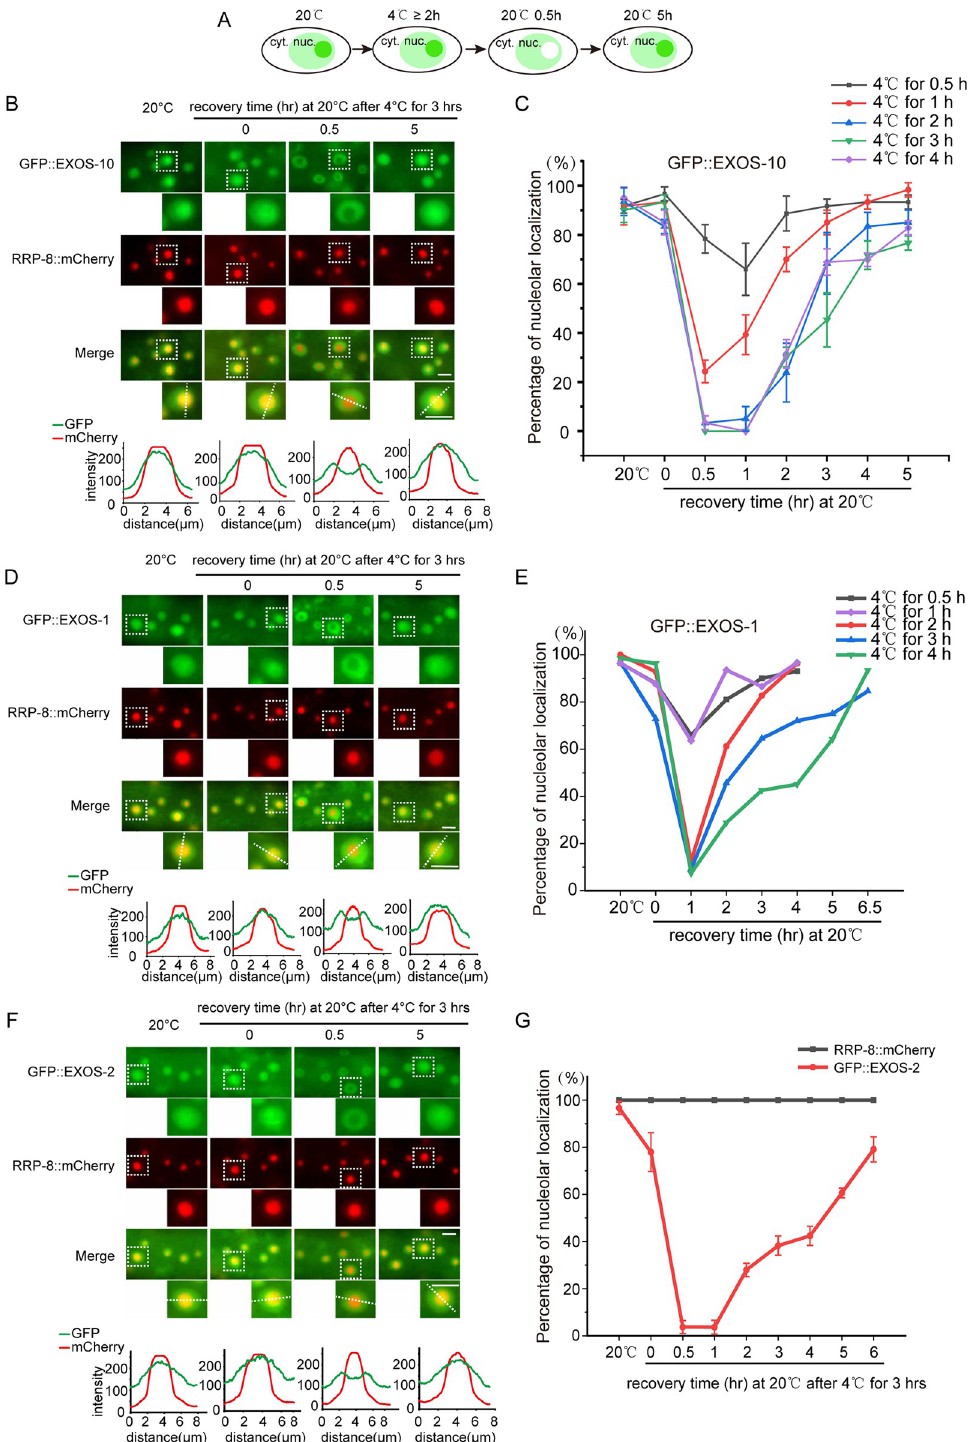
Fig 1. Cold-warm induced depletion of the RNA exosome complex from the nucleoli. (A) The model shows the subcellular localization of EXOS-10 after cold-warm shock. cyt., cytoplasm; nuc., nucleus. (B) Images show epidermal cells of the indicated L3/L4 stage animals expressing GFP::EXOS-10 and RRP-8::mCherry after 4˚C for 3 hours. Animals were shifted to 4˚C for 3 hours followed by recovery at 20˚C for 0.5 hour and 5 hours. The fluorescence intensity indicated by dashed lines was measured by ImageJ. Scale bars, 5 μ m. (C) The curve graph represents the percentage of